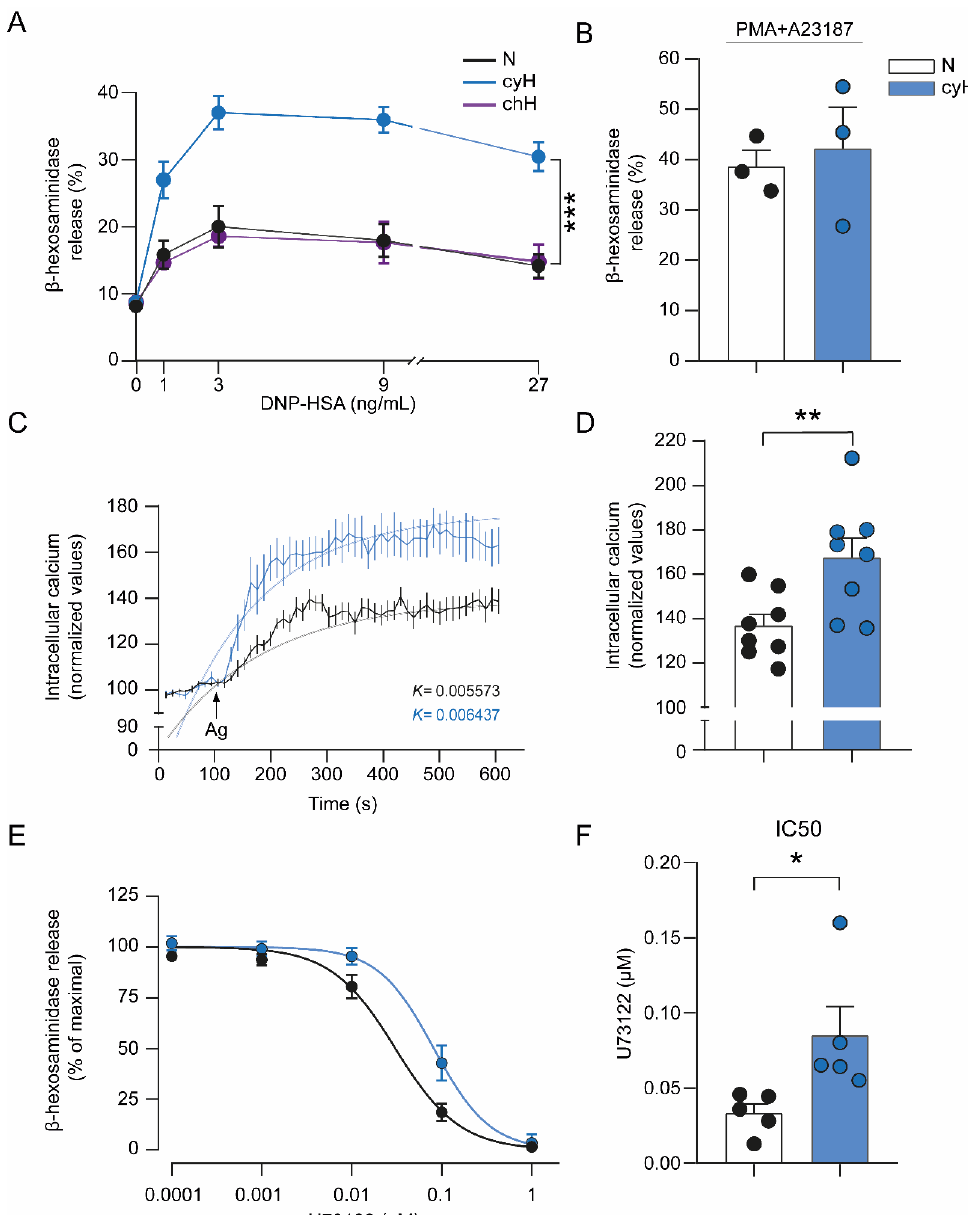
Figure 4. Cyclic hypoxia increases IgE/Ag-dependent degranulation and intracellular Ca 2+ mobilization, together with an overactivation of PLC- γ in BMMCs. Two million BMMCs were exposed to different conditions and sensitized with 100 ng/mL IgE 1 h before the end of each protocol. Cells were then stimulated with a specific Ag DNP-HSA. ( A ) Release of β -hexosaminidase in BMMCs incubated under normoxic conditions (2.5 h at 21% O 2 , N), cyH (H2), or chH (2.5 h at 1% O 2 ) and stimulated with different concentrations of Ag for 30 min. ( B ) Two million BMMCs were exposed to N or cyH and then stimulated with 1 μM of both PMA and A23187 for 30 min . The release of β -hexosaminidase was then determined in the cell´s supernatants. ( C ) Ten million BMMCs were incubated in N or cyH and loaded with Fura 2-AM as described in the Materials and Methods section. Basal Fura 2-AM fluorescence was recorded for 100 s, and then cells were stimulated with 27 ng/mL Ag. Fluorescence was recorded during 600 s and the rate constant, K, was calculated by fitting a monoexponential function. ( D ) Bar graph illustrating the maximum intracellular Ca 2+ rise under N and cyH conditions. ( E ) Two million BMMCs were exposed to N or cyH and then preincubated with different concentrations of the PLC inhibitor U73122 for 15 min in normoxic conditions. Cells were then stimulated with Ag (9 ng/mL) for 30 min . The percentage release of β -hexosaminidase was measured as described in the Materials and Methods section. ( F ) Bar graph representing the half- maximal inhibitory concentration (IC50) values at which degranulation is inhibited in normoxic and